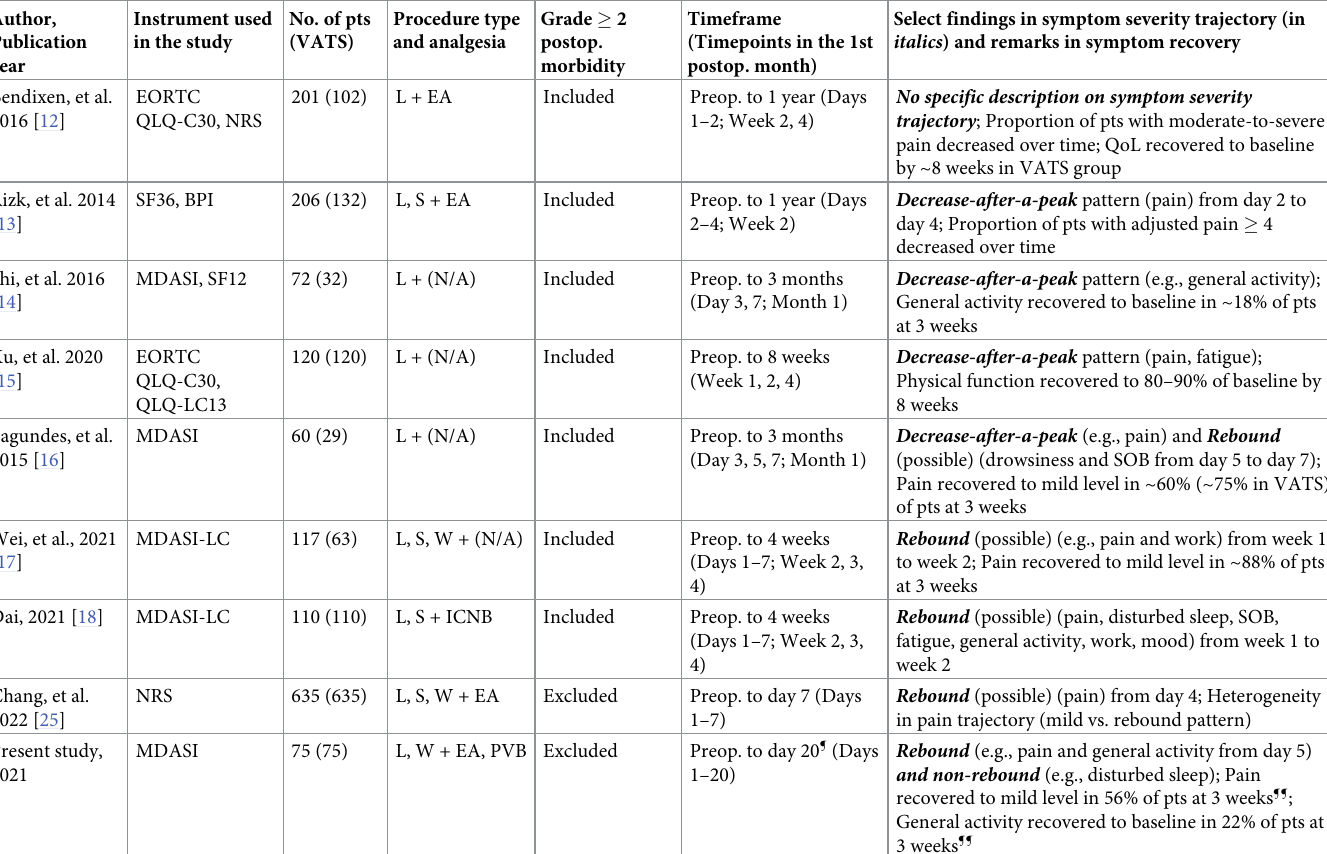
Table 3. Summary of longitudinal studies reporting PROs of patients undergoing VATS for lung resection with � 1 timepoint within the first postoperative week